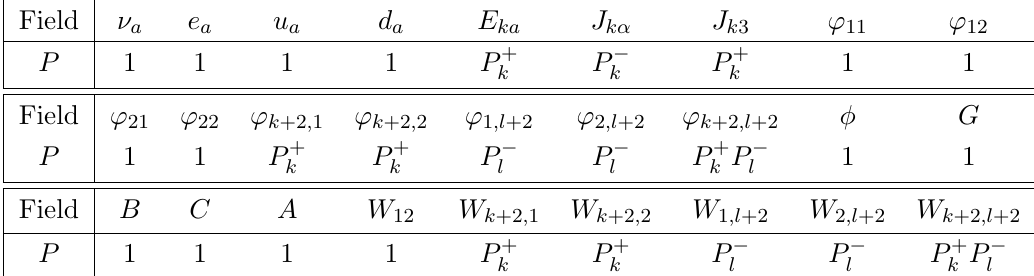
Table 1 . The multiple matter parity P value of the model particles, where P (cid:6) and k; l = 1 ; 2 ; 3 ; ; P 2. Additionally, G , B , C , A and W ’s denote the gauge bosons associated (cid:1) (cid:1) (cid:1) (cid:0) with the color, X , N , the Cartan and weight raising/lowering